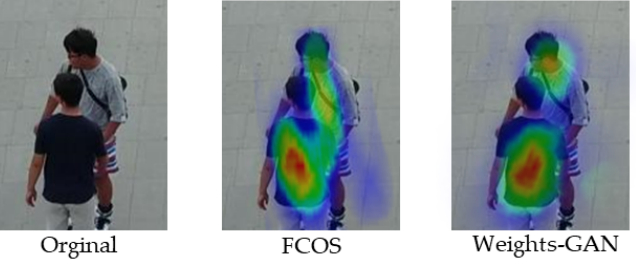
Figure 8. Occluded objects feature map visualization of FCOS and weight-GAN